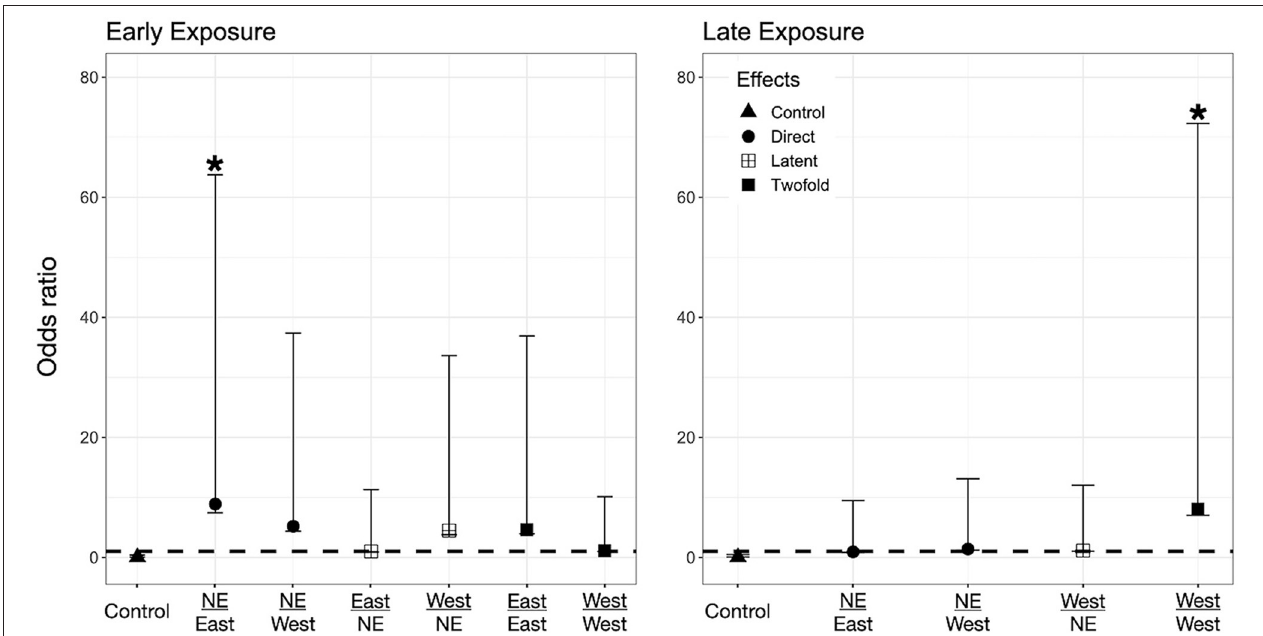
FIGURE 3 | Odds ratio (OR) for P. regilla tadpoles according to their exposure regimes. Label of x-axis includes a fraction that indicates in the numerator the exposure regime as embryo and in the denominator exposure regime post-hatching (no exposure = NE, East or West for Bd chytrid strain). A dashed line indicates value 1. OR > 1 higher risk after exposure, OR = 1 no risk difference, OR < 1 lower risk after exposure. A star (*) indicates treatments with significant odds ratios. Effects are represented as follows: Direct effects –only exposed to Bd as larvae– are represented by circles, latent effects –only exposed as embryos– are represented as four squares, and 2-fold effects –exposed as embryos and larvae– are represented with filled squares; controls are represented by